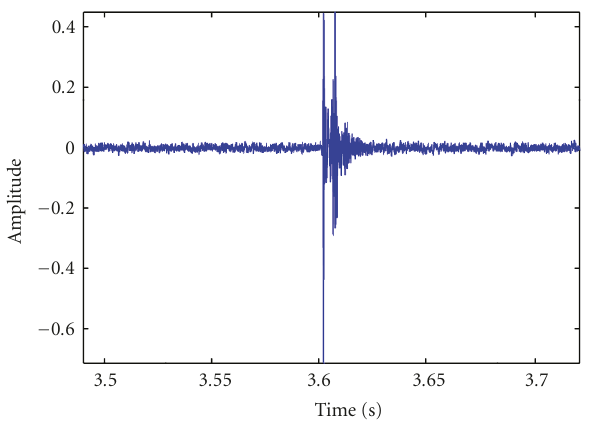
Figure 1: Example for a sperm whale click.